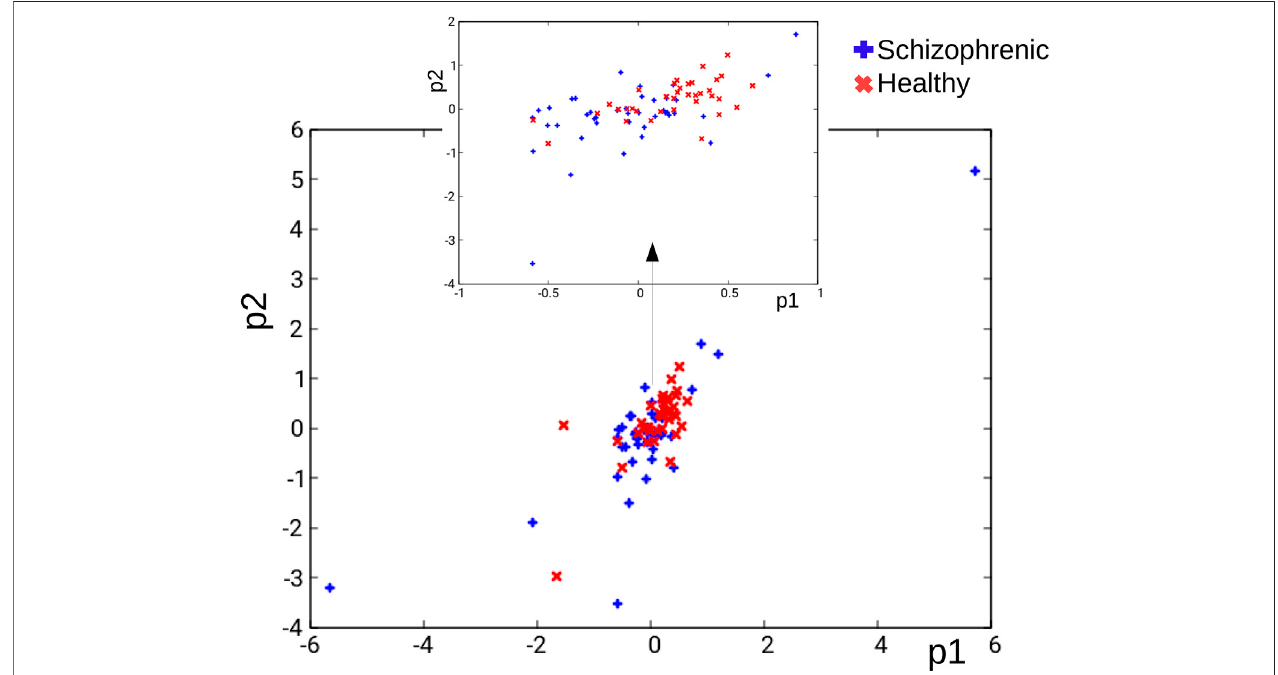
FIGURE 4 | The distribution of records in the T S database in the ( p 1 , p 2 ) coordinates. Blue and red crosses correspond to schizophrenic and healthy cases, respectively.